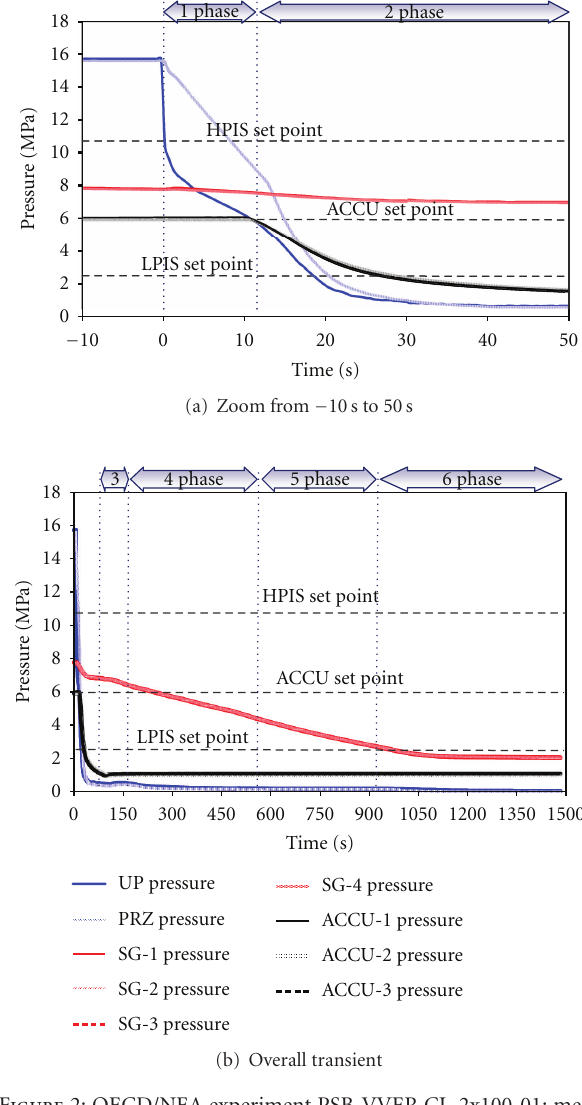
Figure 2: OECD/NEA experiment PSB-VVER CL-2x100-01: mea- sured trends of upper plenum (YC01P16), pressurizer (YP01P01) steam generators (YB01-04P01), and accumulators pressures